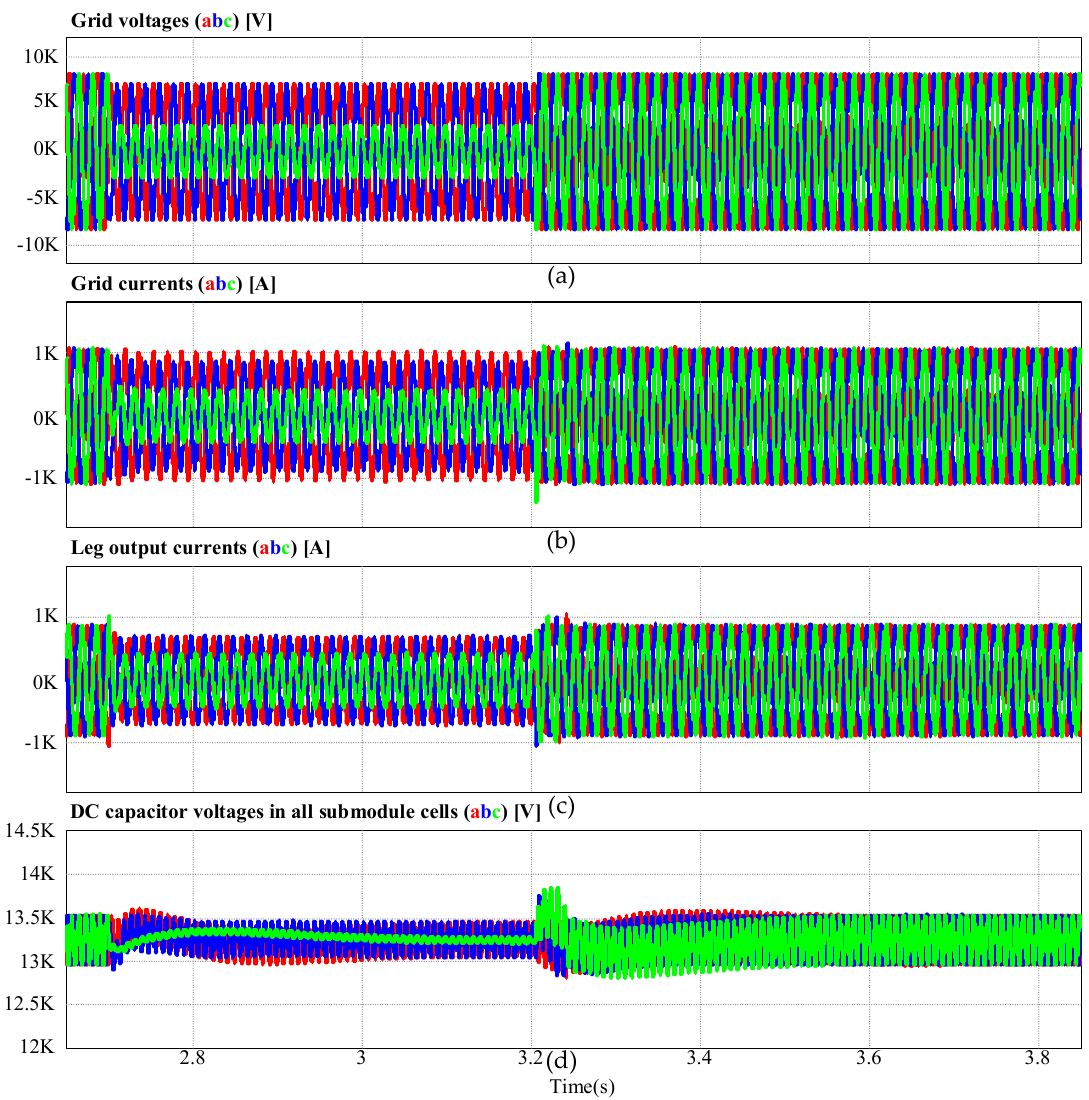
Figure 8. Simulation results under unbalanced grid conditions when the proposed feedforward is applied: ( a ) three-phase grid voltages; ( b ) three-phase grid currents; ( c ) three-phase leg output currents; ( d ) DC capacitor voltages in all submodule cells.